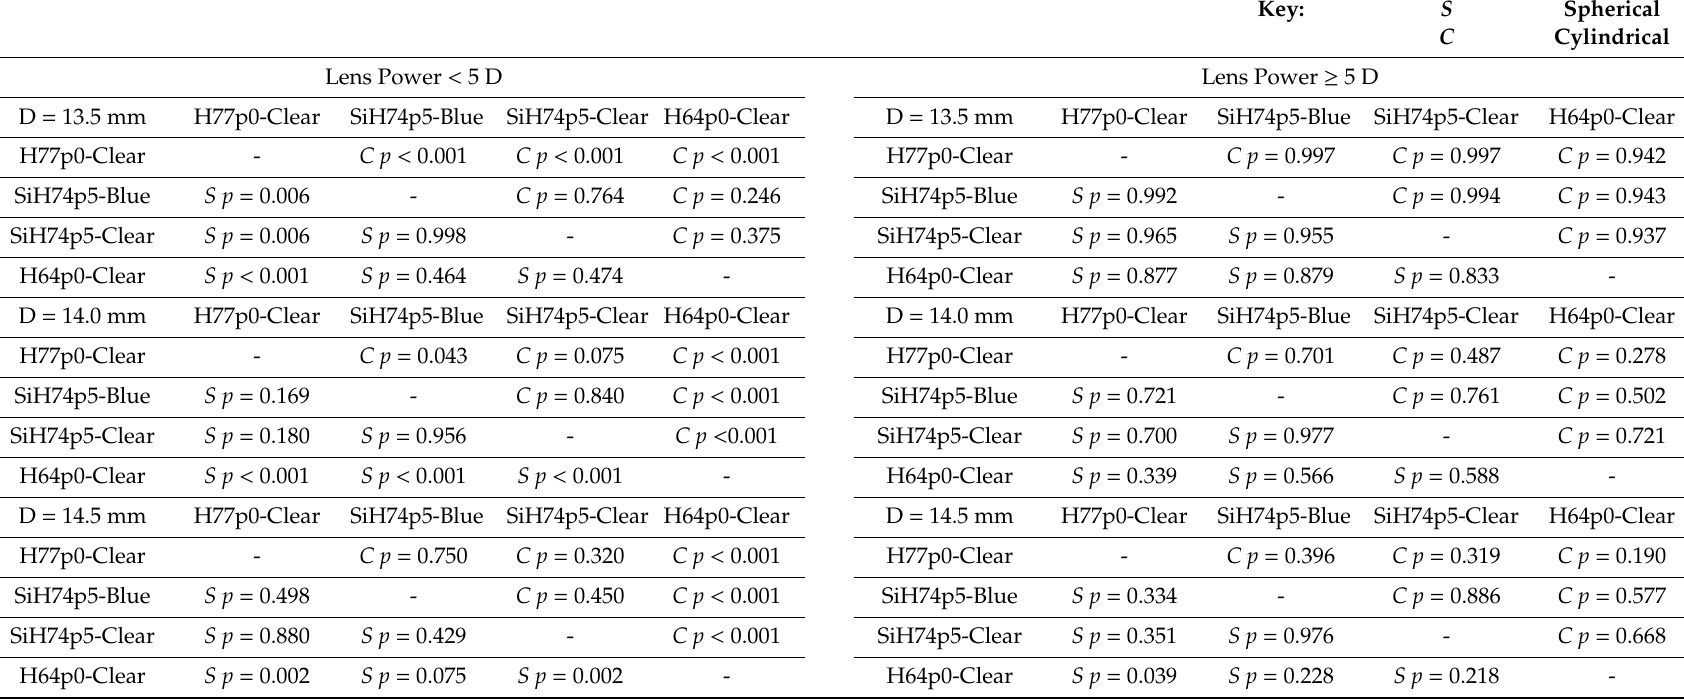
Table 4. Significance values for comparing the e ff ective power change (EPC) results for each of the four materials. The EPC in each lens power region was recorded for each lens material, type (spherical or cylindrical), and diameter. These values were then used to compute the significance provided within the table. Due to the di ff erence in behaviour in the two regions of each graph, the significance values of these regions were calculated separately. Results used for comparison are presented in Figures 8 and